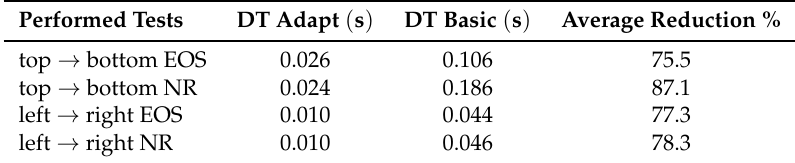
Table 1. Comparison between the collision Detection Times (DT) of the basic version and the adaptive one.